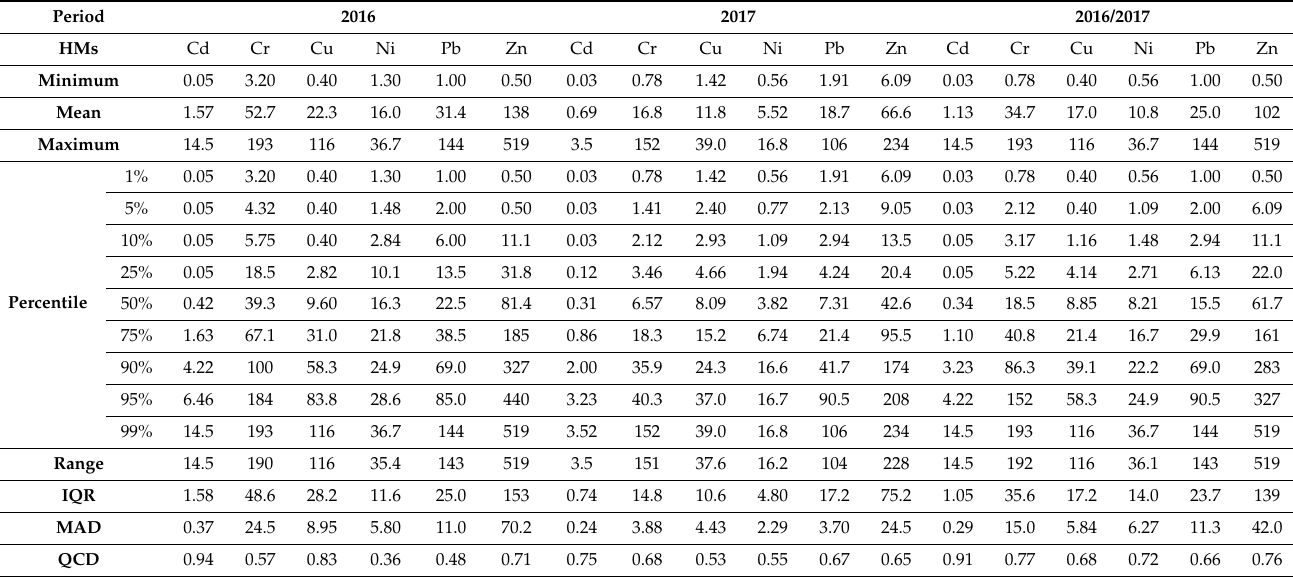
Table 6. The characteristic concentrations of heavy metals (mg.kg − 1 ) in the Warta River bottom sediments in 2016 and 2017.